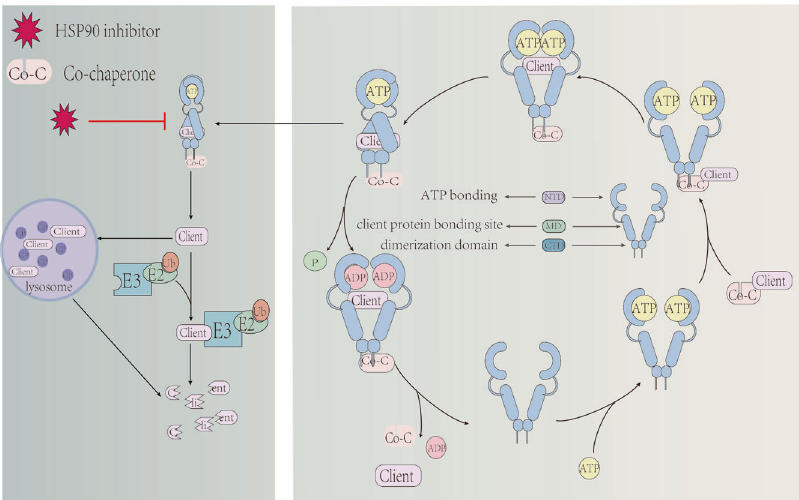
Fig. 1 HSP90 regulates the stability and degradation of clients. Client is regulated by forming the complex of HSP90, co-chaperone and client, whose prerequisite is the ATP-binding HSP90. When the complex complete assembly, the conformation of HSP90 changes and ATPase is activated which takes participate in the process of client. The inhibition of HSP90 affects the complex to promoting client unstable, leading the degradation of client by lysosome and ubiquitinated protease